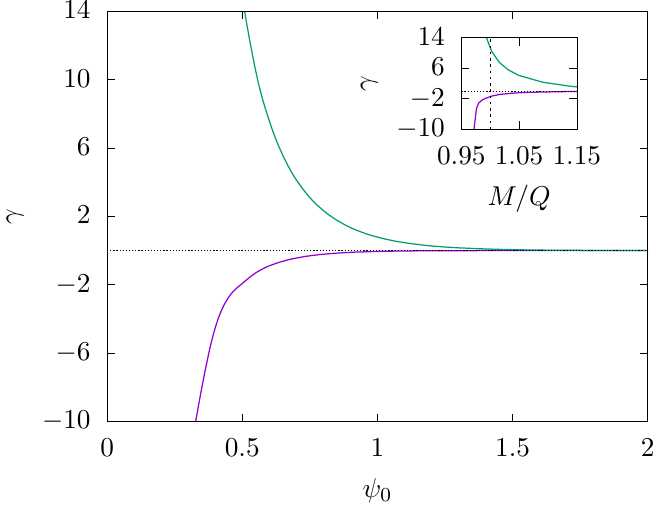
Figure 4 . We show the value of γ in dependence on the central boson star value ψ 0 for which solutions of (3.4) exist when α = 0. In the inset, we also show γ in dependence on the ratio between the mass M and the Noether charge Q of the background boson star. Note that boson stars with M/Q < 1 are stable with respect to decay into Q bosons of mass m the M/Q = 1 line (black dotted).